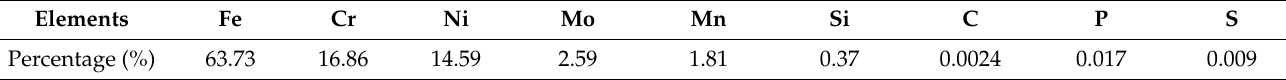
Table 1. Chemical composition of the metallic